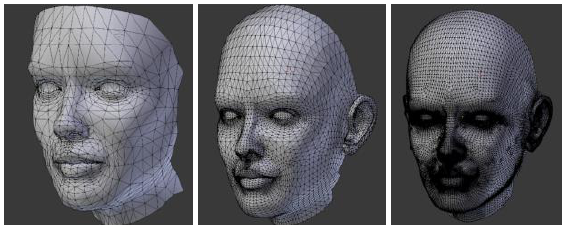
Figure 4. Deformable head 3D model with ”low” (~900 triangles), ”medium” (~5000 triangles) and ”high” (~20000 triangles) spatial resolution.